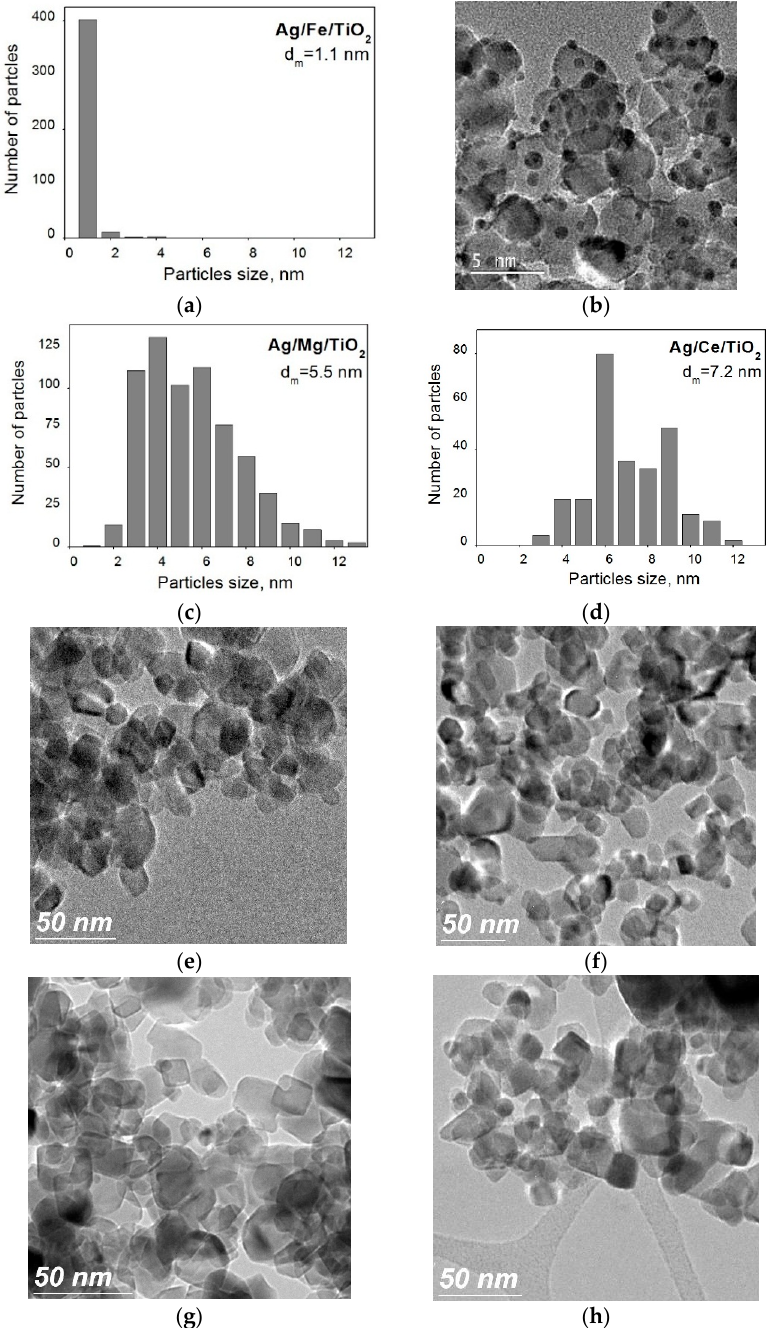
Figure 2. Particle size distribution of Ag catalysts supported on Fe/TiO 2 ( a ), Mg/TiO 2 ( c ) and Ce/TiO 2 ( d ) treated in H 2 at 300 °C for 1 h. Microphotographs of catalyst Ag/Fe/TiO 2 ( b ) and supports: Fe/TiO 2 ( e ), Mg/TiO 2 ( f ), Ce/TiO 2 ( g ) and TiO 2 ( h ).